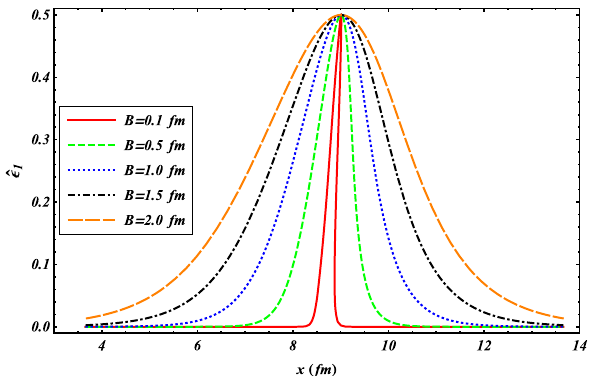
Fig. 4 Solutions at t = 15 f m for different widths of the initial wave. A = 0 . 5, q = 1 . 08, and T = 140 MeV